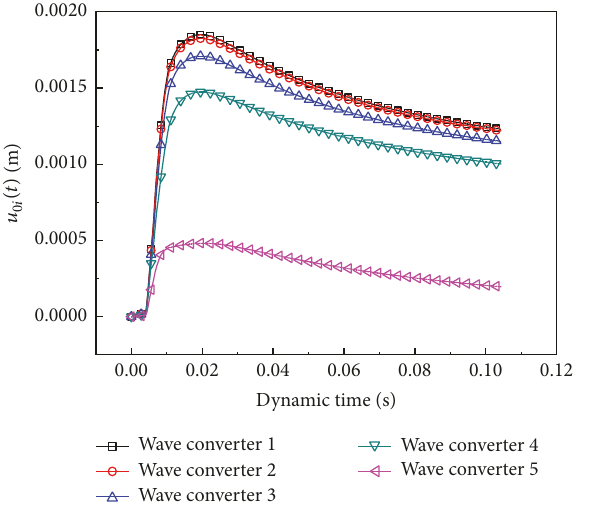
Figure 14: Curves of 𝑢 2𝑖 (𝑡) with time.